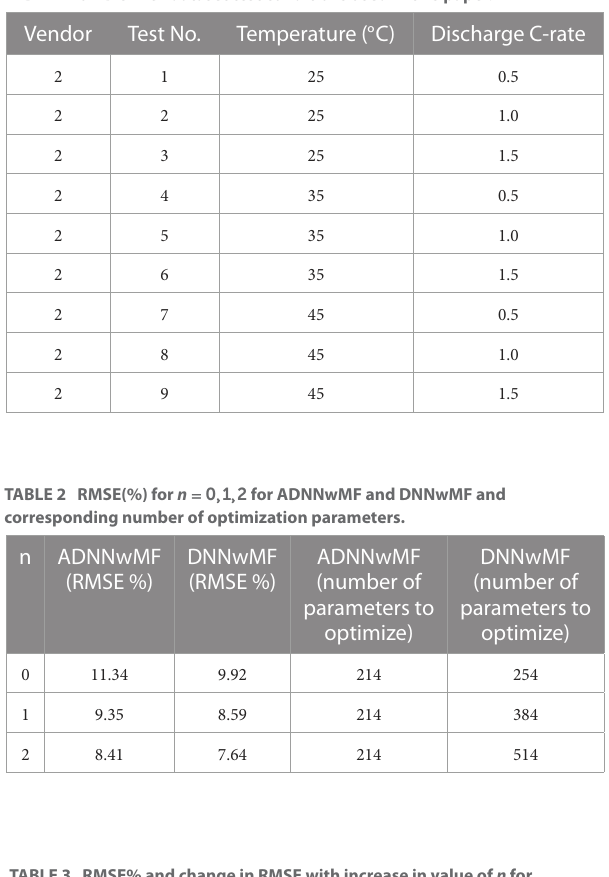
TABLE3 RMSE%andchangeinRMSEwithincreaseinvalueof n for